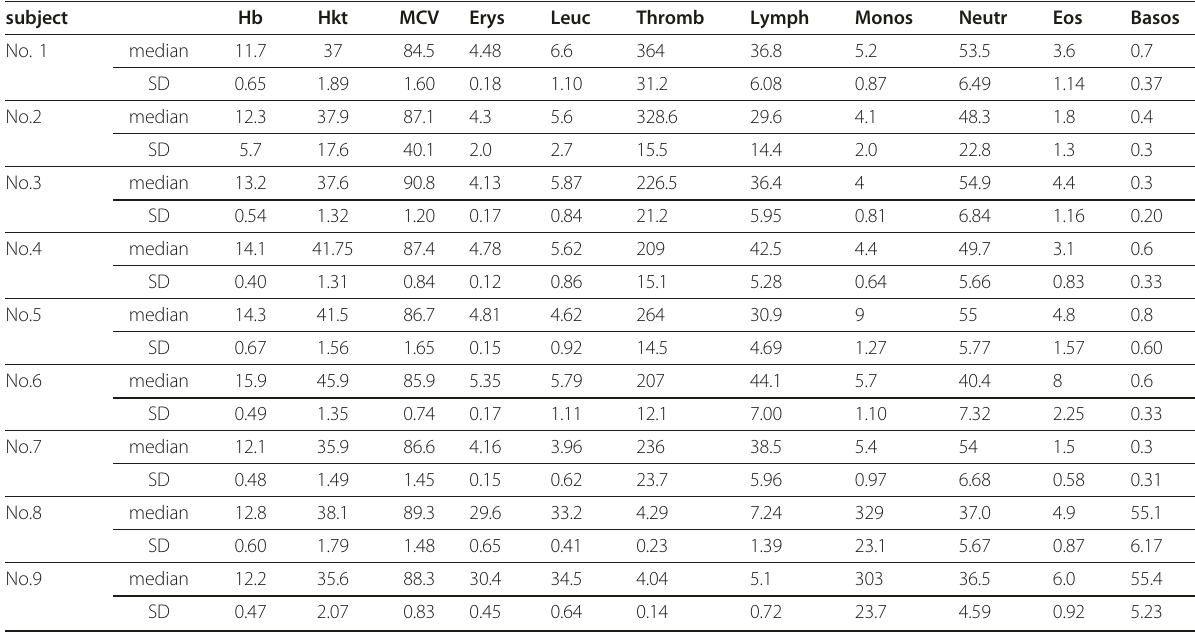
Table 4 Laboratory testing - haematology